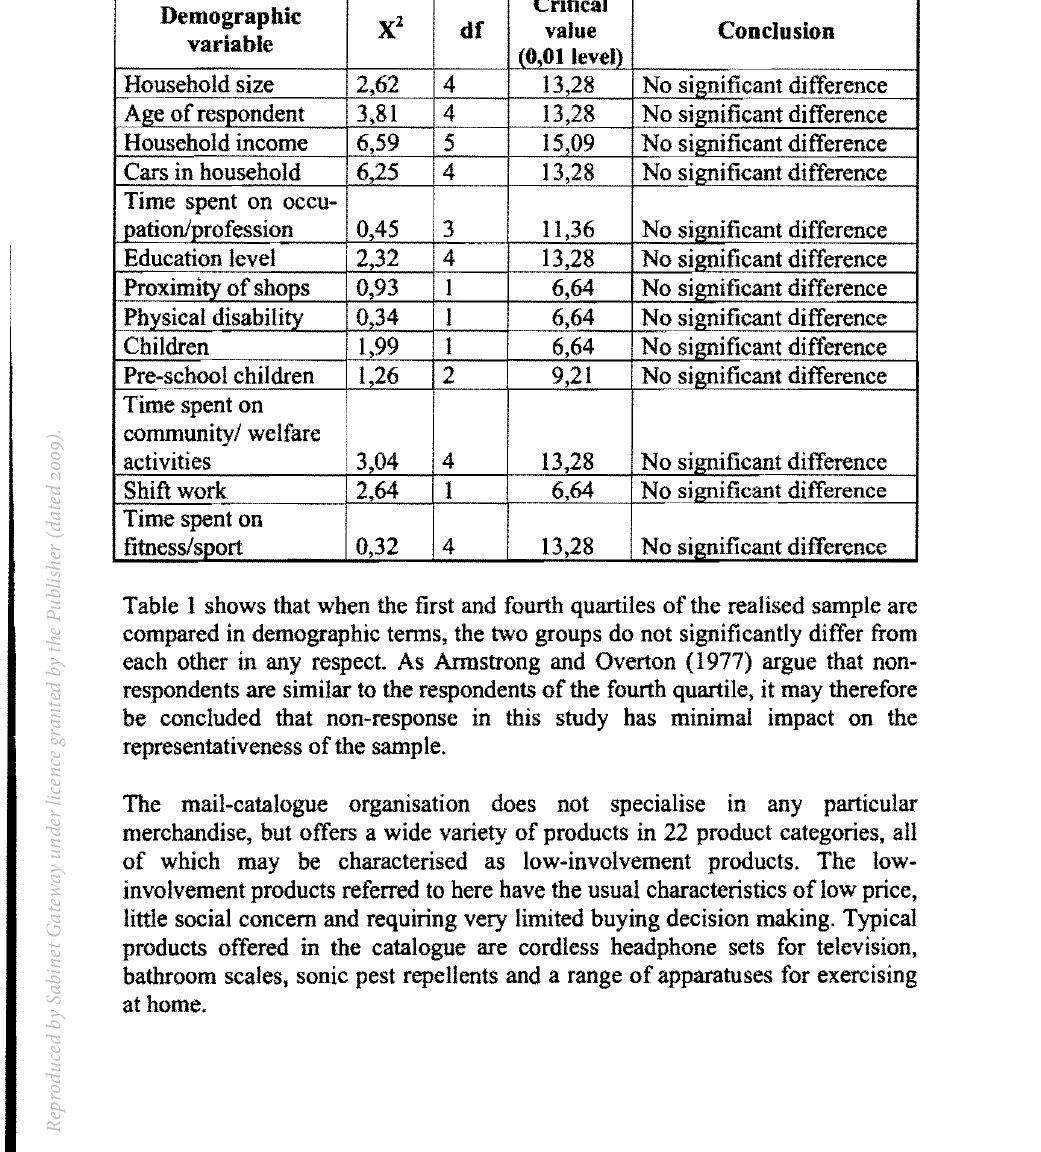
Comparison of first and fourtb quartiles of tbe sample with regard to demographic characteristics by using a